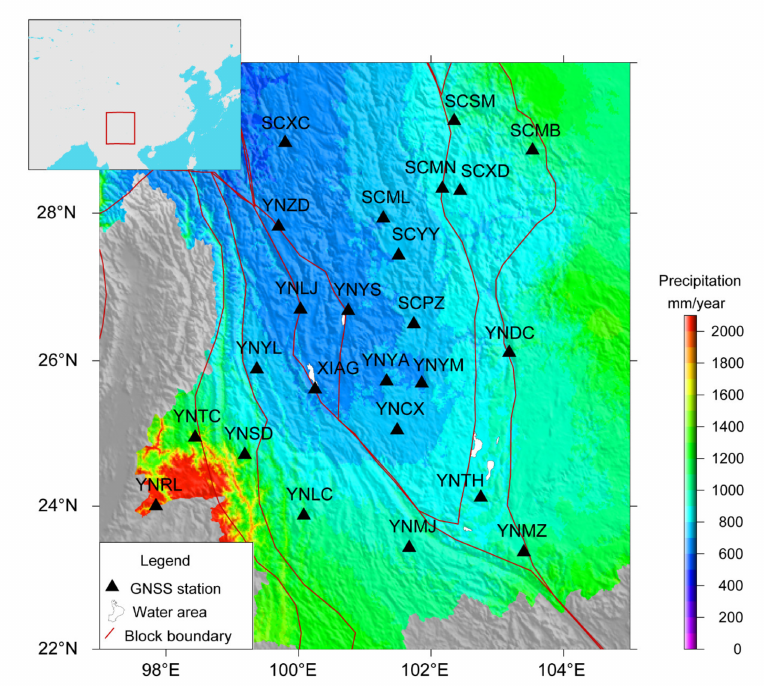
Figure 1. Distribution of GNSS stations in the research area. The gray background is the topography of the study area, and the colored background is the average annual